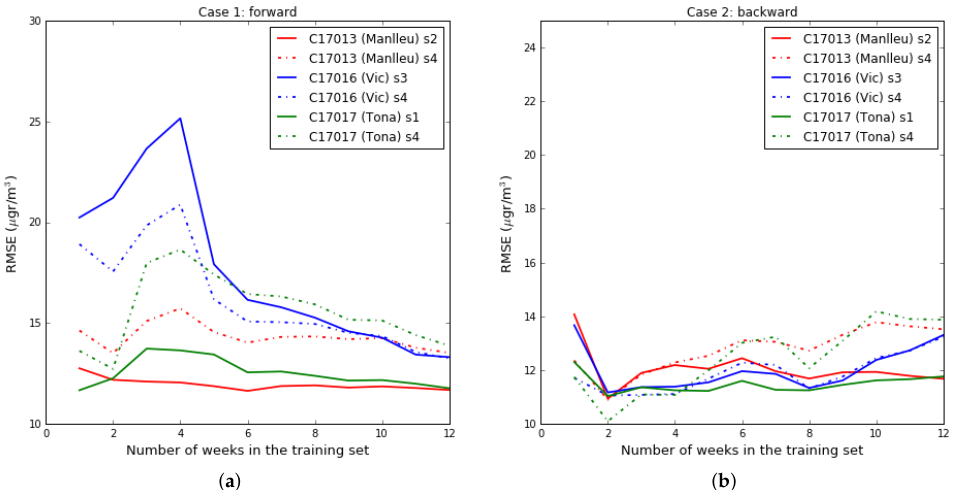
Figure 9. ( a ) Case 1: Training data increases in forward direction, ( b ) Case 2: Training data increases in backward direction.